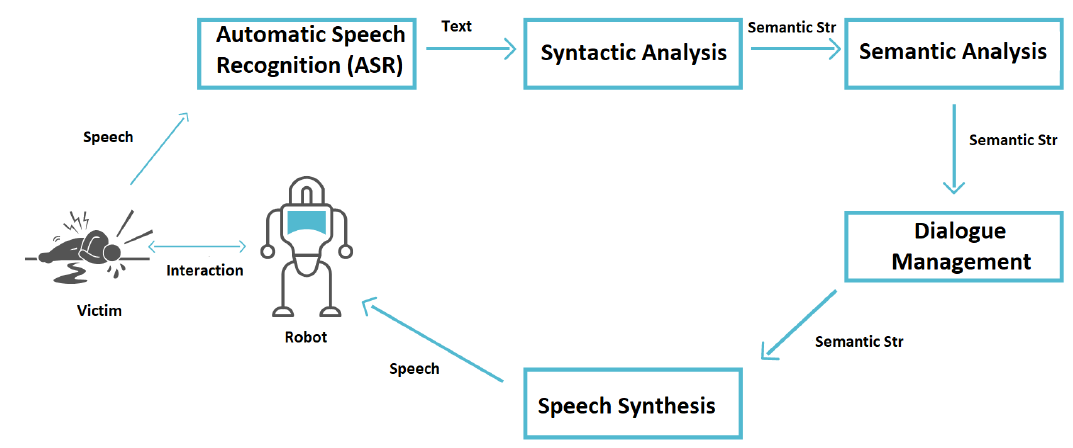
Figure 3. The dialog management architecture that we have implemented into our robot, which handles text-to-speech and speech-to-text vocal